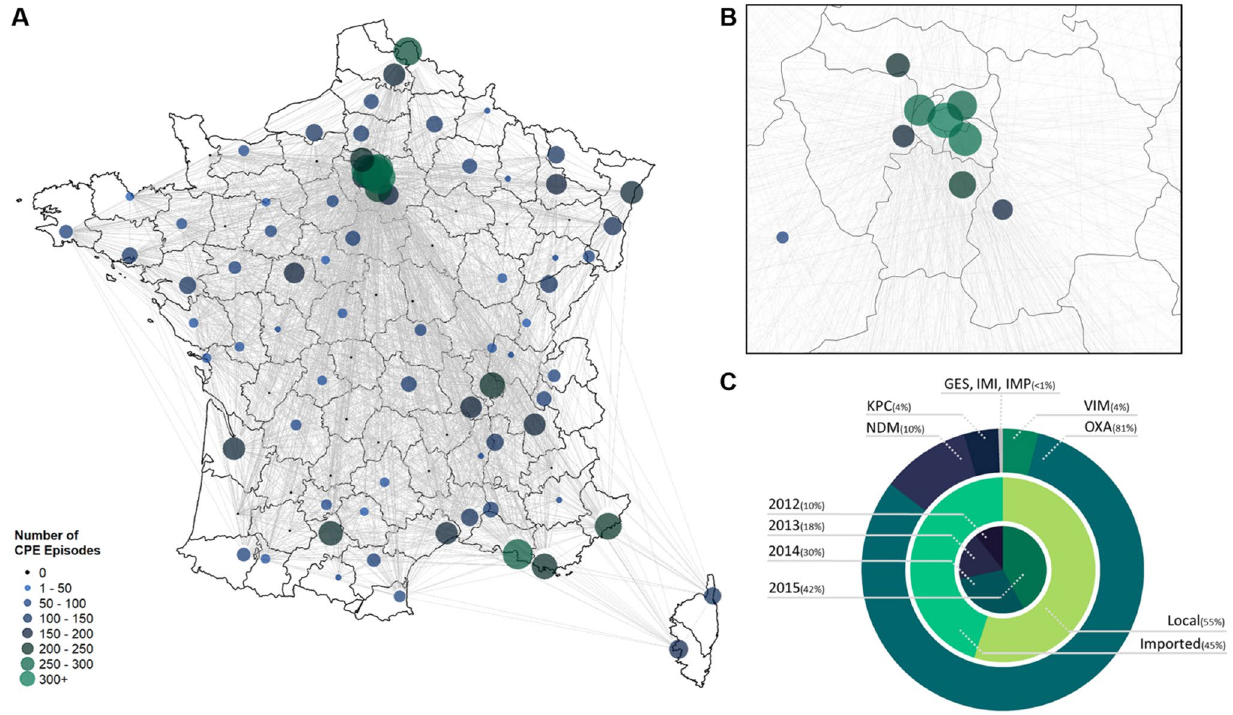
Figure 1. Network of patient transfers between French counties and incident CPE episodes reported between 2012 and 2015. ( A ) The county network is comprised of 96 counties linked together by over 3,000 connections (grey lines). Patient transfer links were centralized to the county seat. For each county, the cumulative number of incident CPE episodes reported in healthcare facilities of the county from 2012 to 2015 is depicted by a circle. ( B ) A zoomed-in view of the Ile-de-France region. ( C ) A multi-level pie chart showing the proportion of incident CPE episodes for each year, along with their importation status and mechanisms of